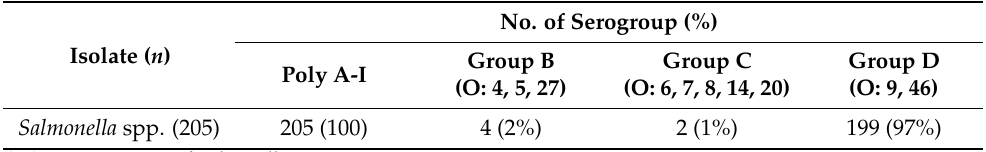
Table 5. Results of serogrouping in Salmonella positive isolates ( n =